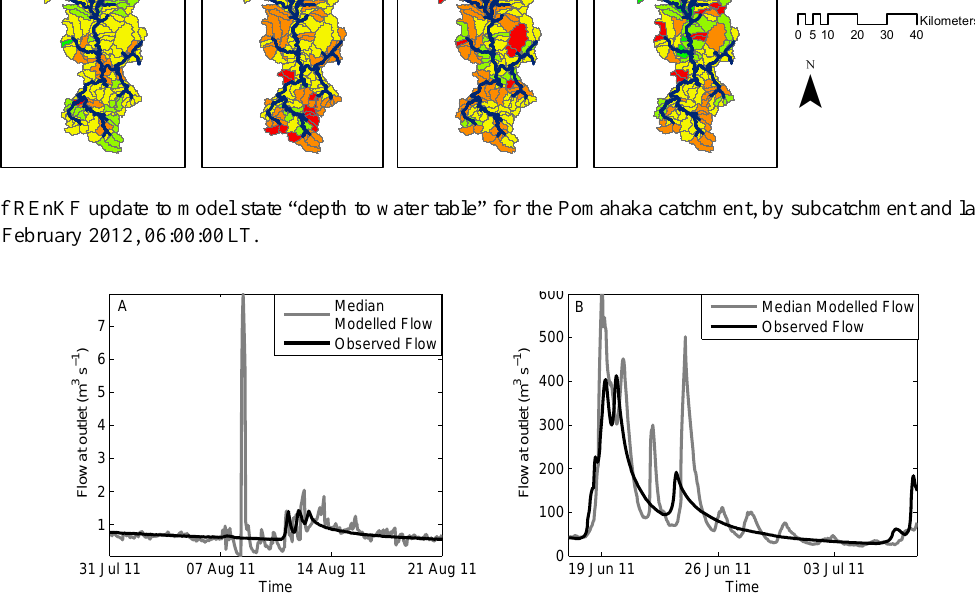
Fig. 15. (A) Spike in modelled flow for the Waihua River when using the ensemble Kalman filter. (B) Oscillations in modelled flow for the Motueka River when using the ensemble Kalman filter.